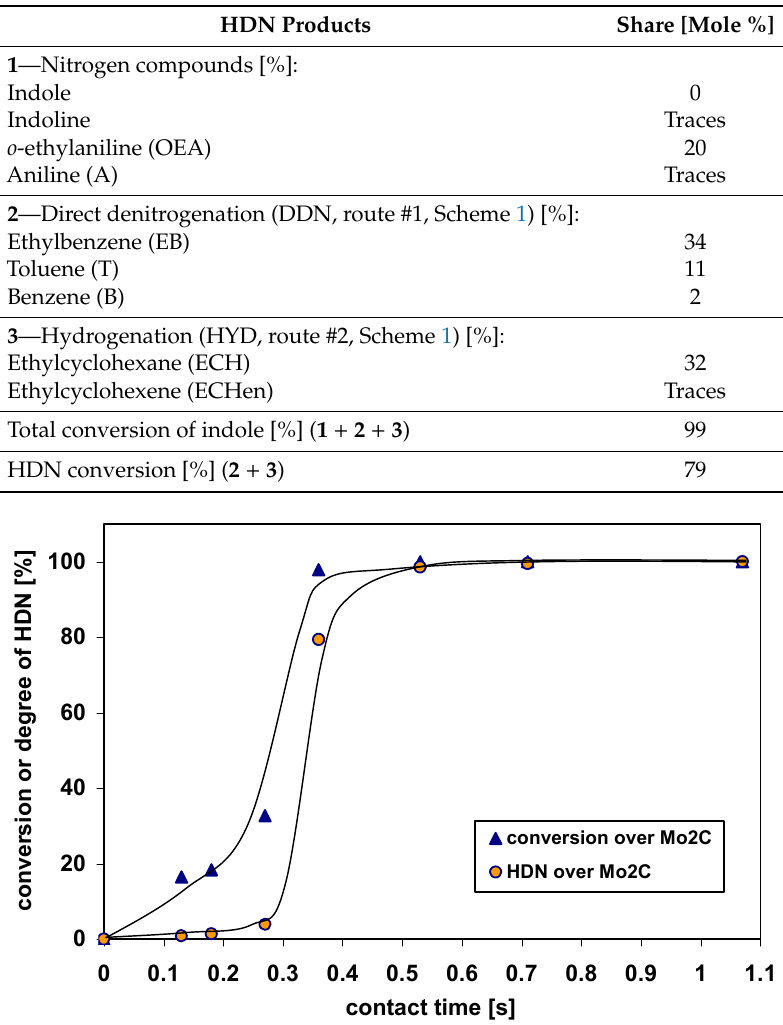
Figure 2. Total conversion and degree of HDN for hydrodenitrogenation of indole over Mo 2 C. Table 2. Selectivity between route #1 and #2 for Mo 2 C catalyst during indole HDN carried out at 613 K, 6 MPa of H 2 , H 2 / feed = 600, S = 50 ppm.